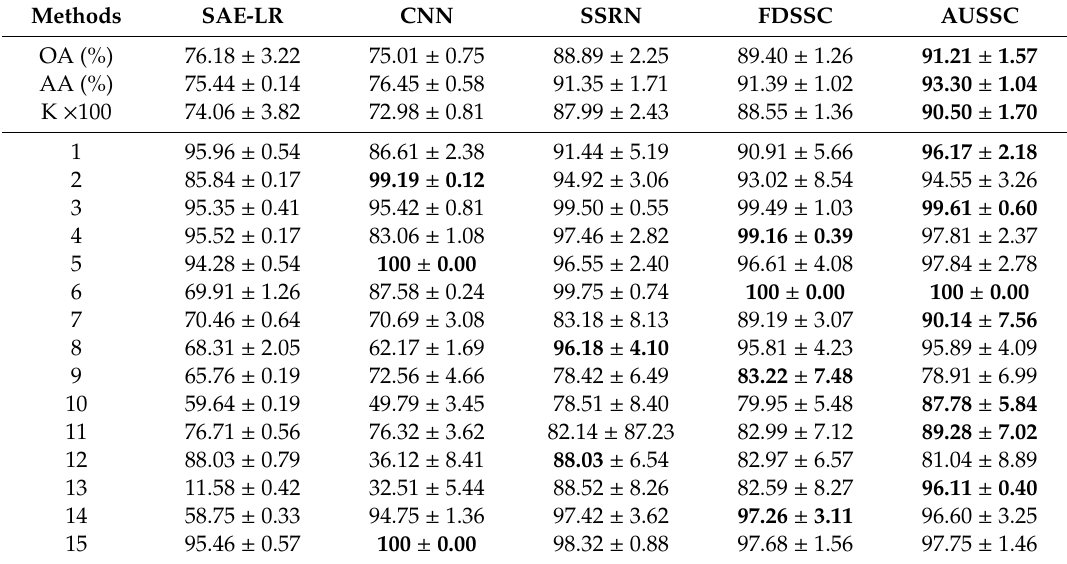
Table 7. OA, AA, K, and accuracy for each HSI category in the Houston data